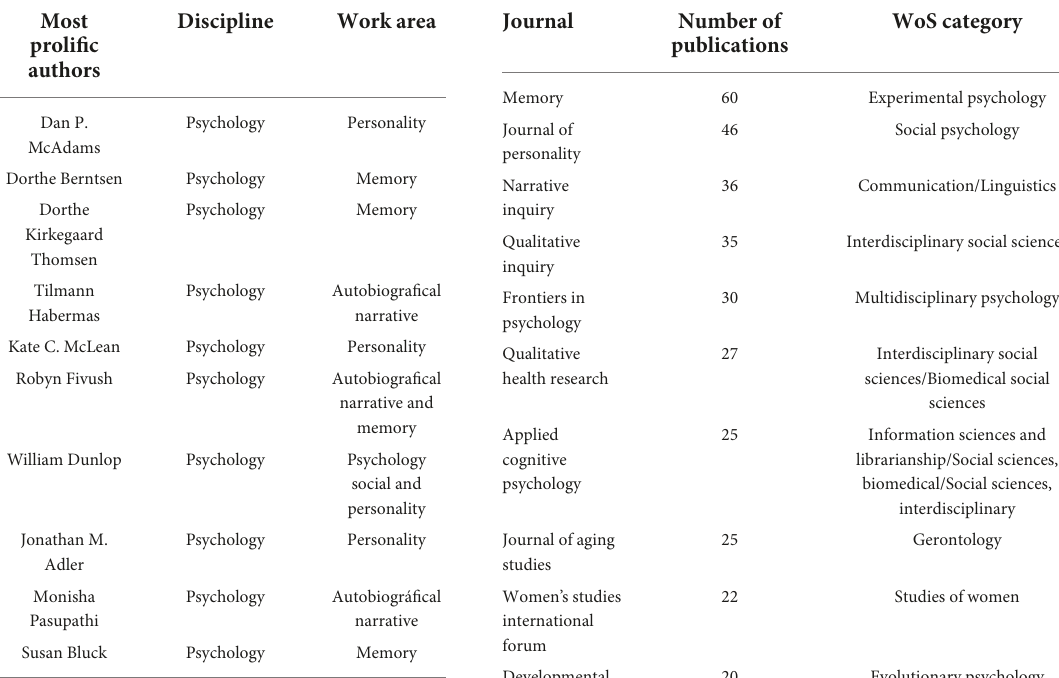
TABLE 1 List of the most prolific